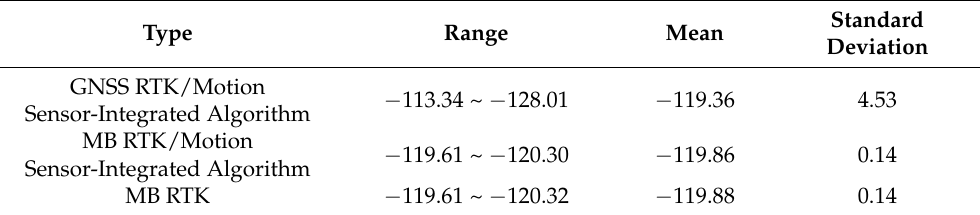
Figure 7. Estimated yaw depending on the type of algorithm. Table 1. Statistics of estimated yaw depending on the type of algorithm (unit: °).